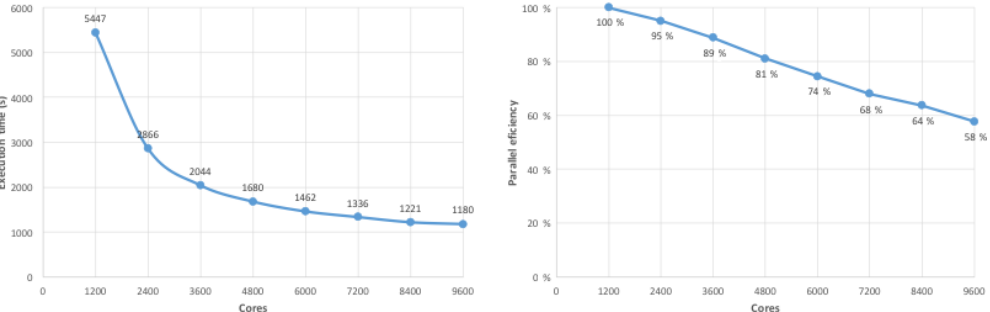
Figure 22. On the left, the execution time of BRAMS on 5km grid spacing covering South America and the adjacent oceans as a function of the number of computing cores. On the right appears the corresponding parallel